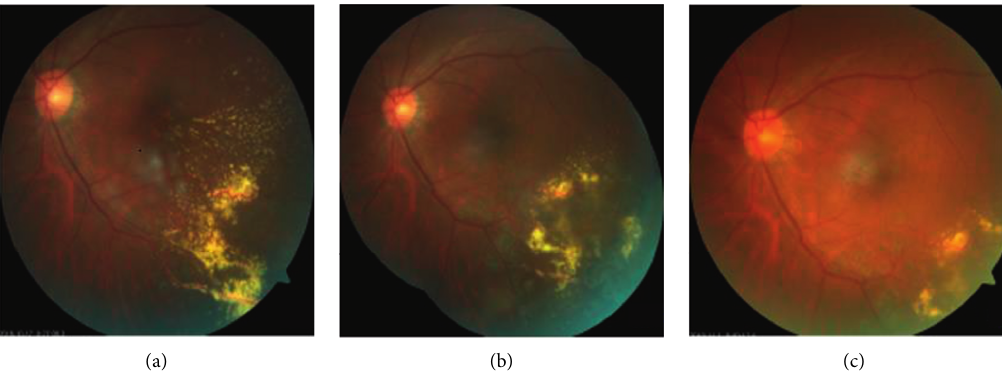
Figure 3: Color fundus photograph of Case 1 in the DEX (+) group before and after the intravitreal injection of DEX implant, conbercept, and laser treatment. The patient was diagnosed with Coats’ disease classified as Stage 3A and consecutively observed for 16 months. 3A: color fundus photograph showing temporal periphery and macular telangiectasia, microaneurysms, large hard exudates, and ERD before intravitreal injection DEX implant, conbercept, and laser treatment; 3B: macular edema and lipid hard exudation were absorbed 4 months after the treatment, while the laser scar can be observed at temporal peripheral retina. 3C: retinal lipid hard exudation was absorbed absolutely at the macular area and temporal peripheral retina 1 year after the treatment.